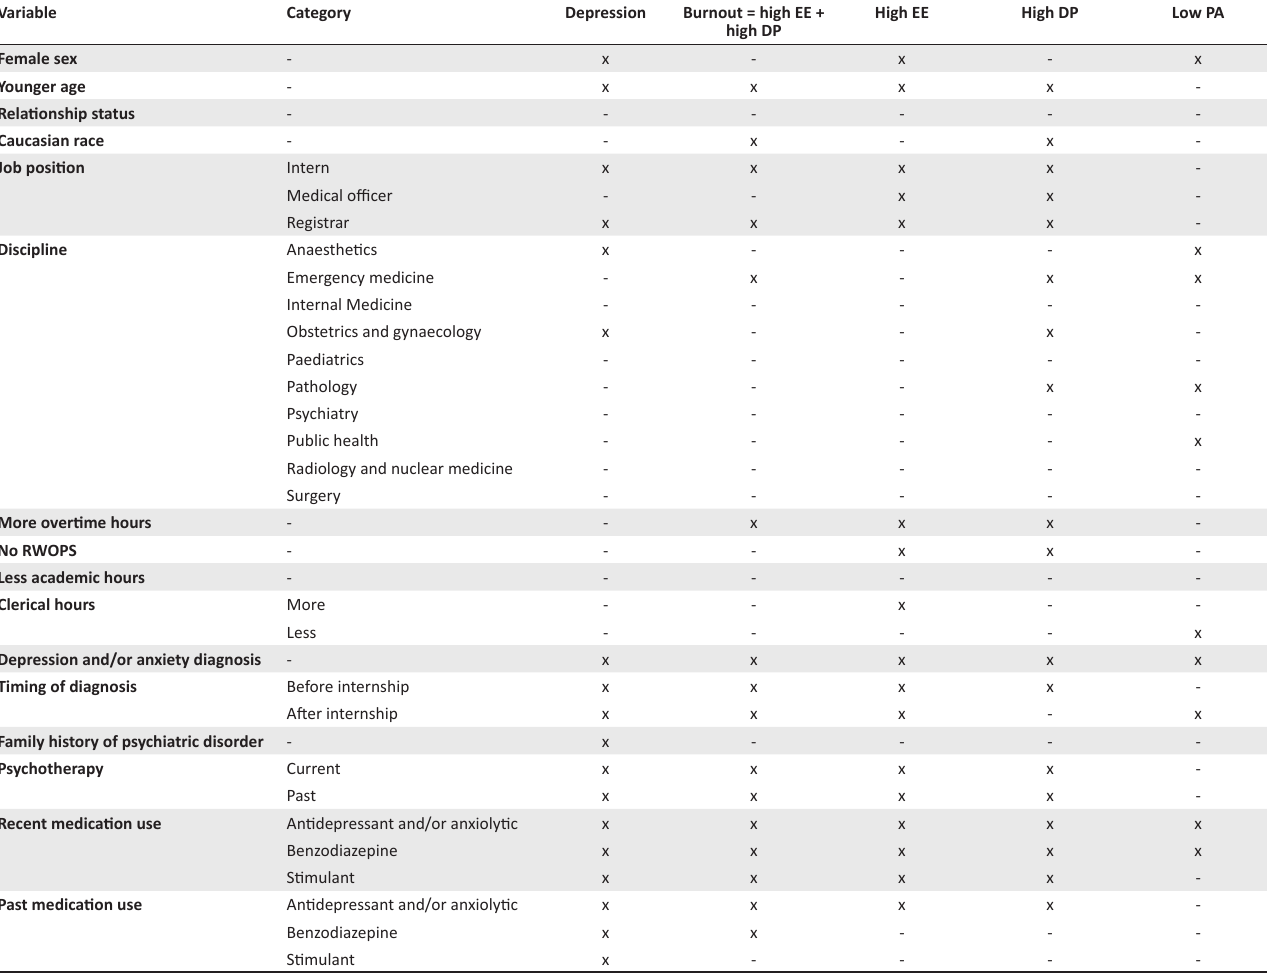
TABLE 5: Summary of significant associations with burnout, burnout subscales and depression.